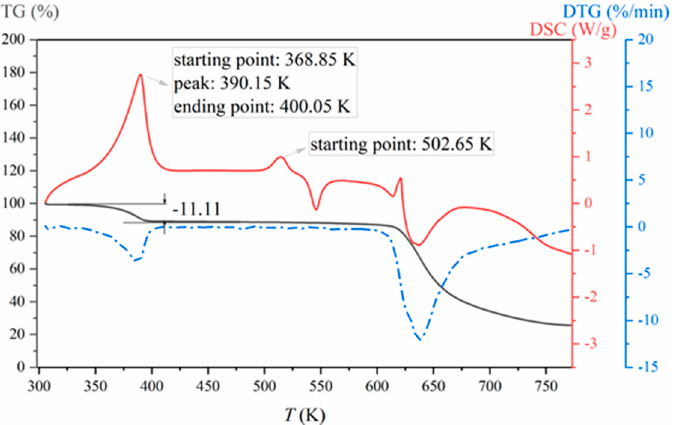
Figure 6. The DSC curve (red color), TG curve (black color) and DTG curve (blue color) of LCZ696.